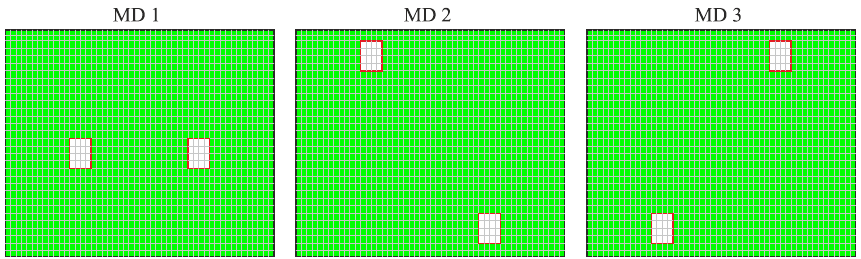
Fig. 9 3 multiple-damage scenarios